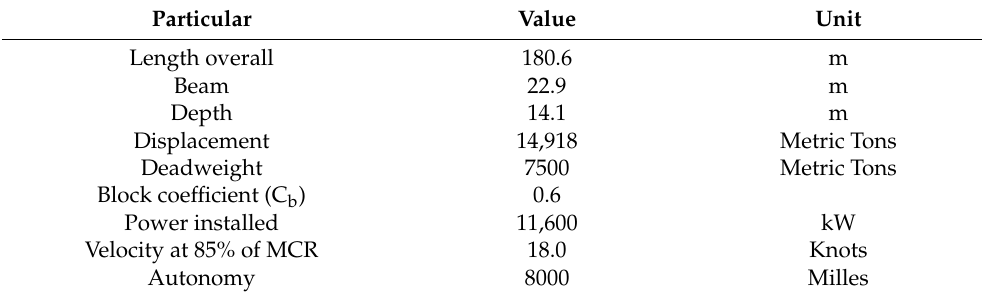
Table 1. Main particulars of ship selected.